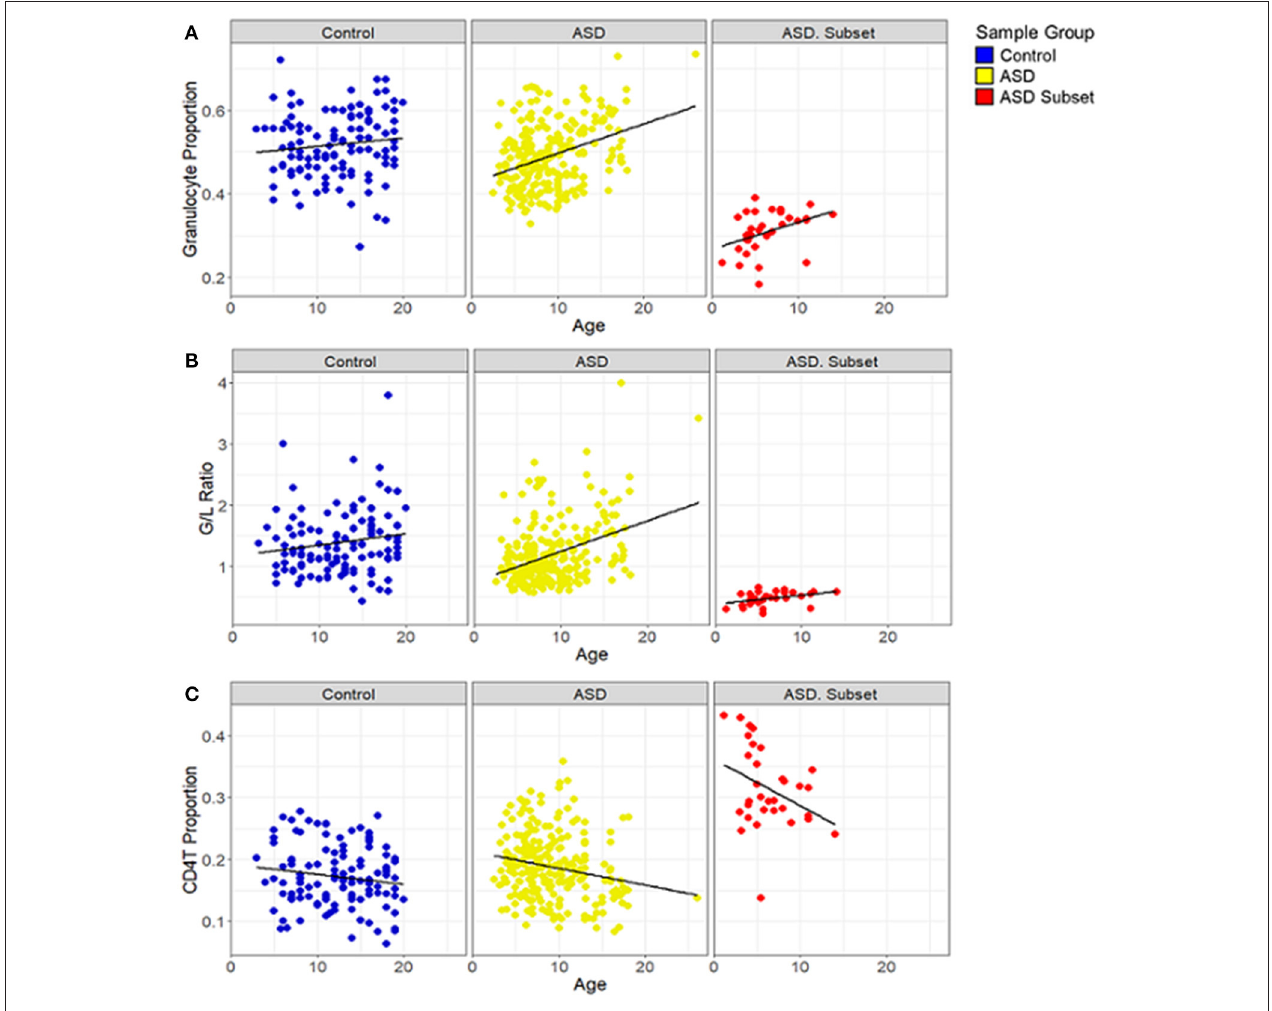
FIGURE 5 | Relationship between blood cell proportions and sample age in individuals with ASD. Box plots depict (A) granulocyte proportion, (B) granulocyte/lymphocyte (G/L) ratio and (C) CD4T proportion in samples plotted against age. ASD subset (red; n = 32), the remaining ASD cases (yellow; n = 233), and controls (blue; n = 122). In all both ASD groups, age was positively correlated with the granulocyte proportion (ASD subset: r = 0.43, p -value = 0.01; the remaining ASD: r = 0.35, p -value < 0.001) and the G/L ratio (ASD subset: r = 0.45, p -value = 0.01; the remaining ASD: r = 0.37, p -value < 0.001) and negatively correlated with CD4T (ASD subset: r = − 0.4, p -value = 0.02; the remaining ASD: r = − 0.2, p -value = 0.002); the remaining ASD: r = − 0.2, p -value = 0.002). In controls, no significant correlation was found between age and the blood cell